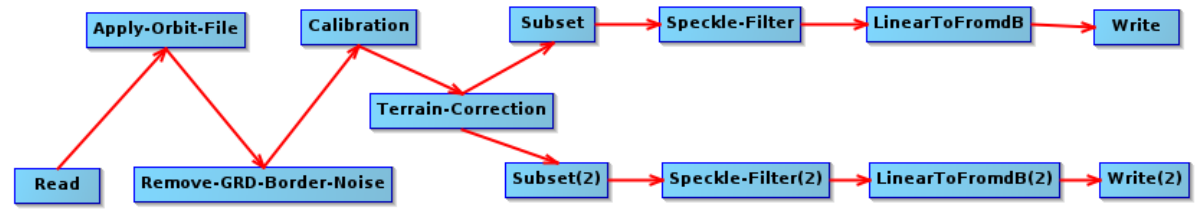
Figure 6. The proposed SNAP graph corresponding to Sentinel-1 images preprocessing